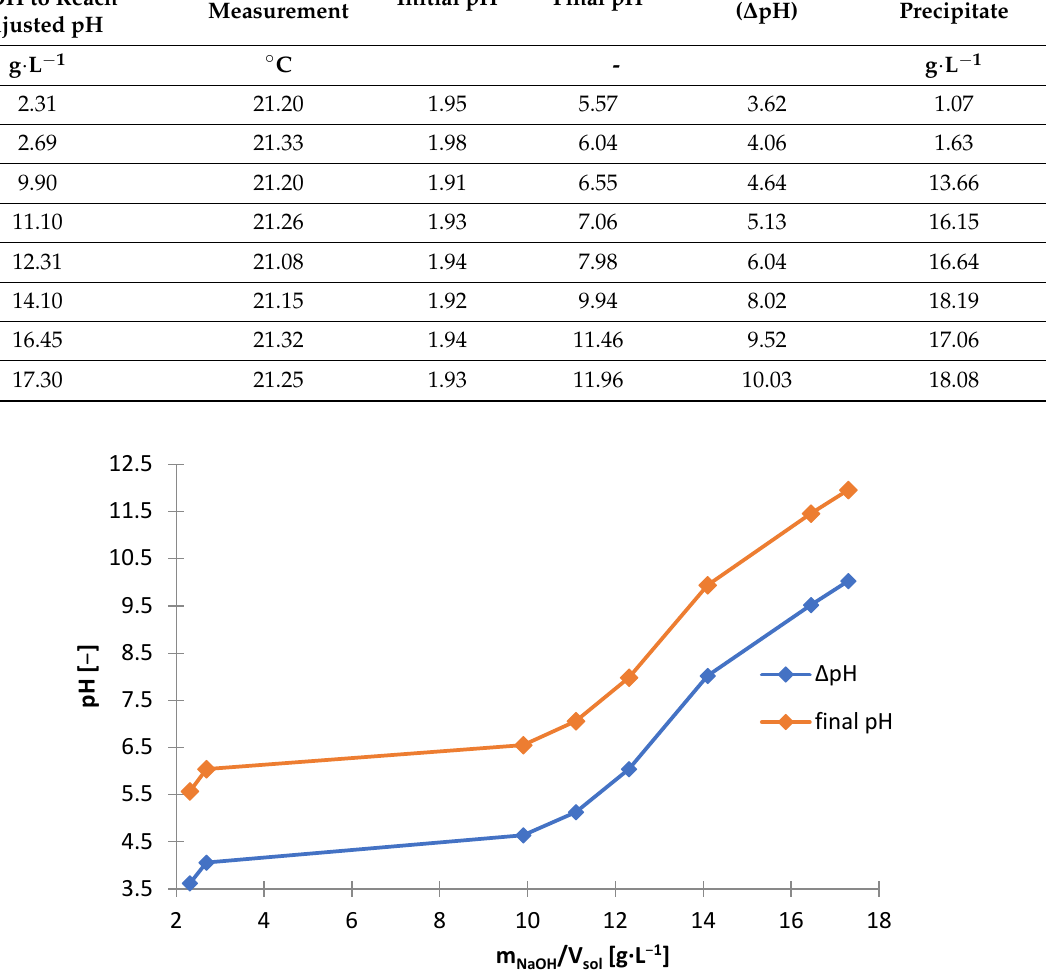
Figure 10. Effect of amount of NaOH (m NaOH /V sol ) on final yield and change in pH during precipi- tation from solution after selective leaching .